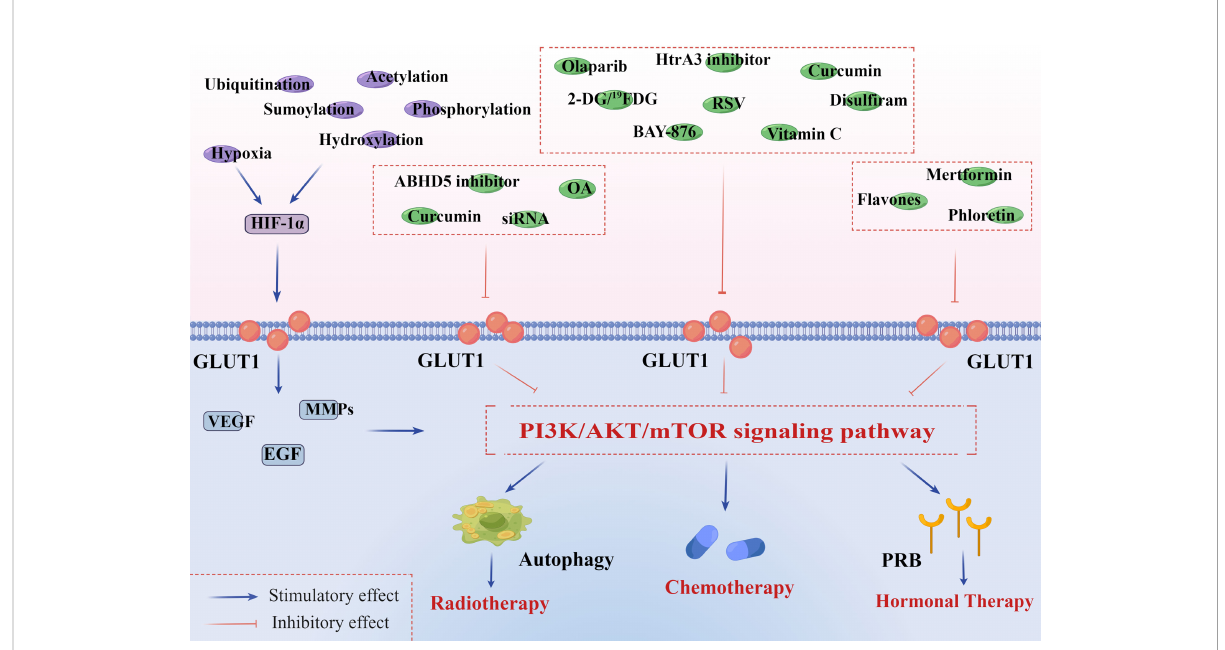
FIGURE 2 PI3K/AKT/mTOR signaling pathway is associated with GLUT1 overexpression and endometrial cancer therapies. HIF-1 a is implicated in both GLUT1 expression and aberrant PI3K/AKT/mTOR signaling pathway in tumor microenvironments. In addition to hypoxia, HIF-1 a can